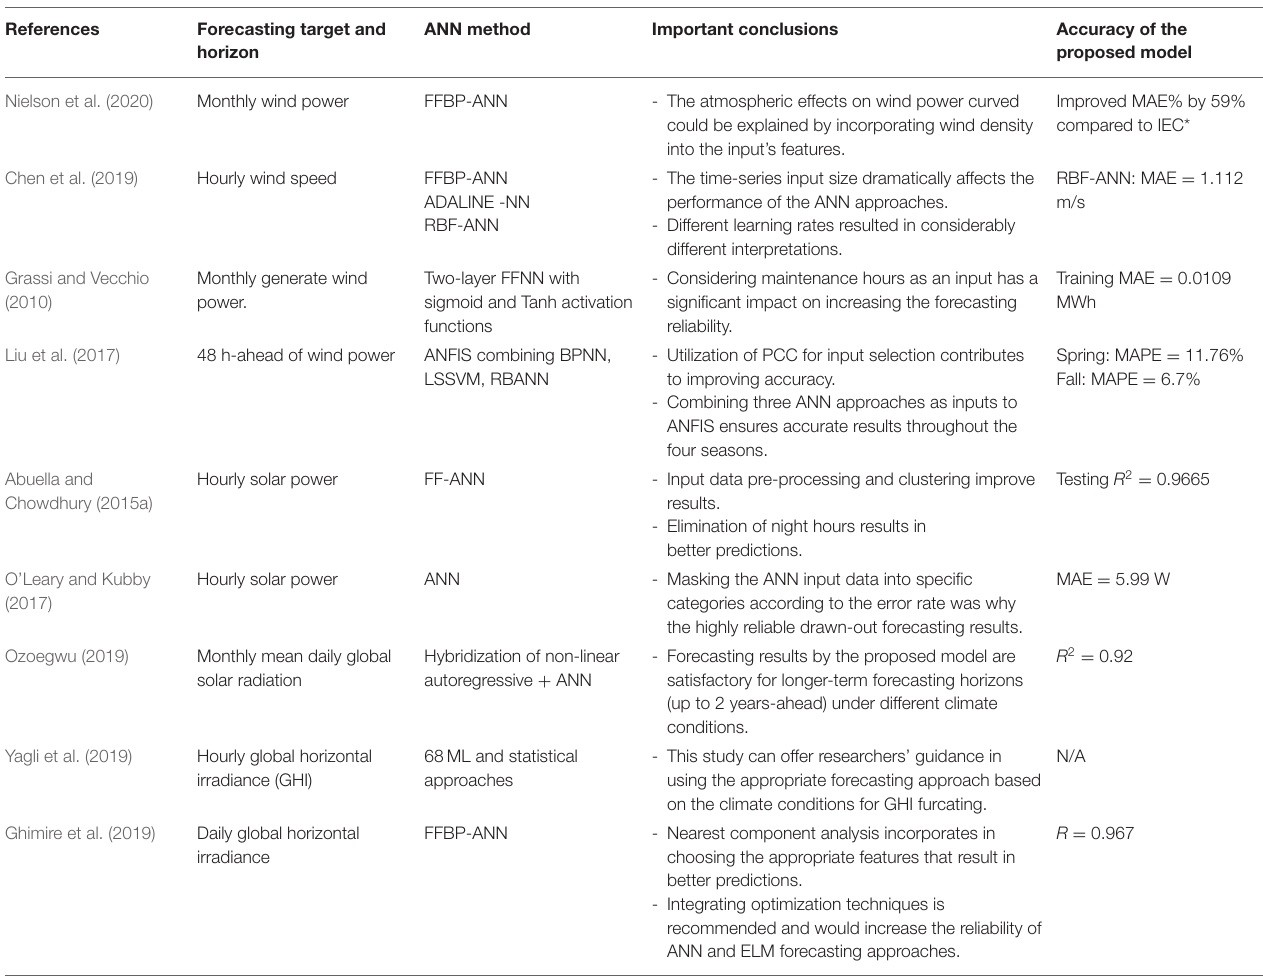
TABLE 1 | Summary of artificial neural network (ANN)